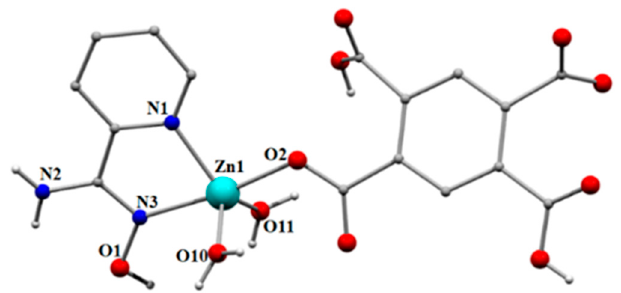
Figure 1. Representation of the mononuclear complex 1 . Color code: Zn, turquoise; N, navy blue; O, red; C, grey.